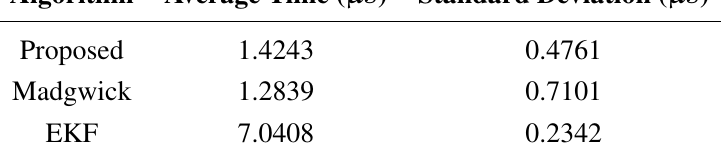
Table 4. Computational time of estimation